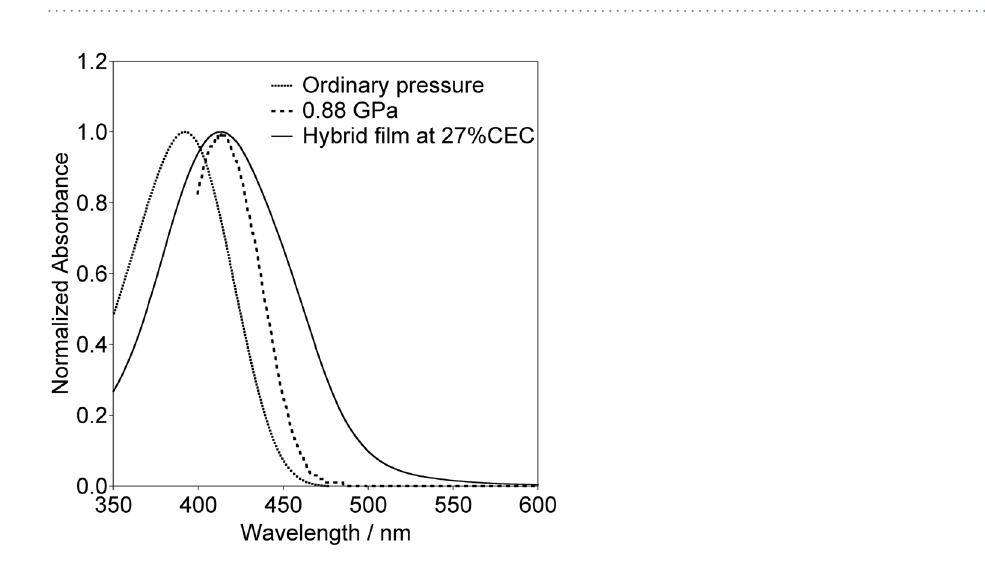
Figure 3. Absorption spectra of BP in a hybrid film fabricated at 27% CEC, and in solution at ordinary pressure and at 0.88 GPa. The BP spectrum at 0.88 GPa could not be measured below 400 nm because of absorption by the window of the diamond anvil